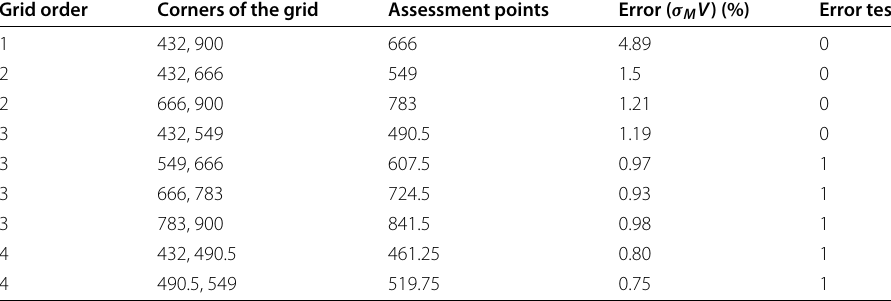
Fig. 11 Localized multigrid refinement in the 1D parameter space: the final sampling points obtained by the final grid are { 432 , 490 . 5 , 549 , 666 , 783 , 900 } Table 3 Illustration of parameter refinement Grid order Corners of the grid Assessment